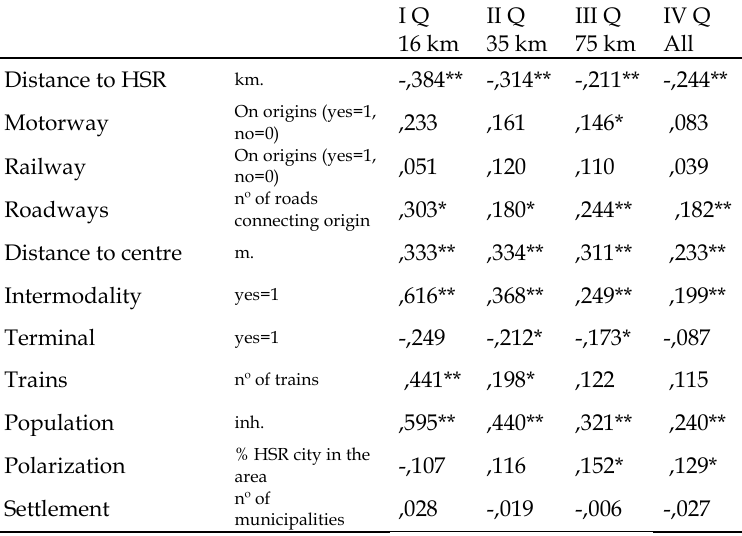
Table 3. Bivariate correlations between independent variables and the ratio of users, and distance thresholds within the catchment